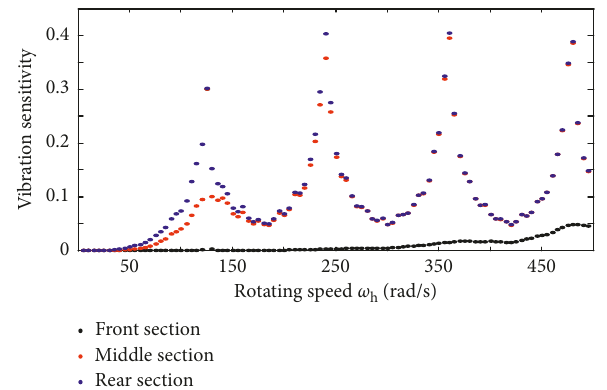
Figure 7: Vibration sensitivity S with varying rotating speed of high-pressure rotor ω h : front section (black), middle section (red), and rear section (blue).